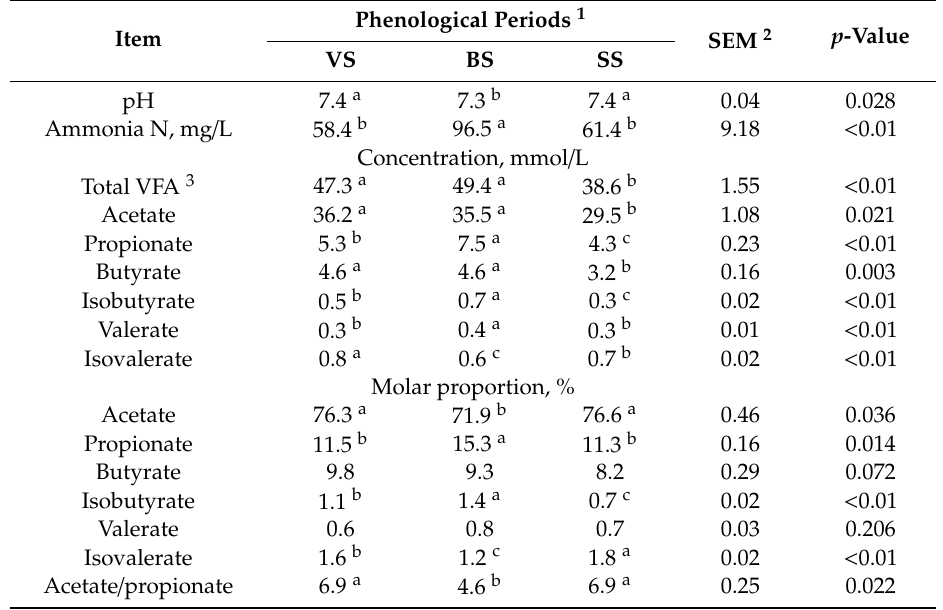
Table 4. E ff ects of herbage in di ff erent phenological periods on ruminal fermentation of